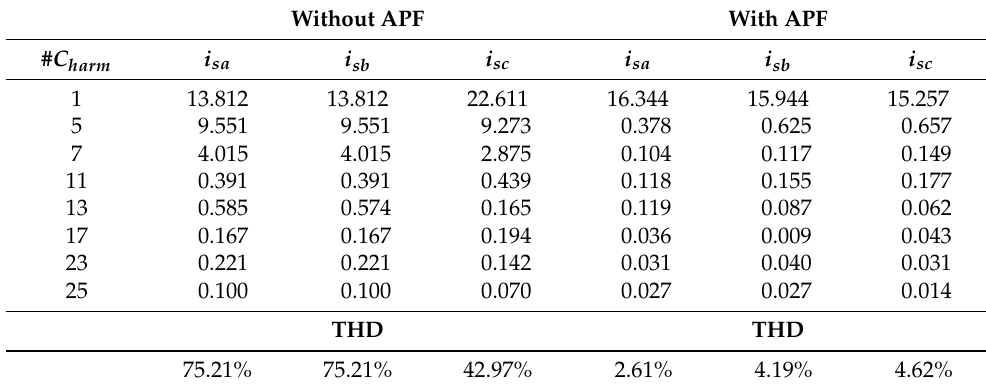
Table 2. Performance results.